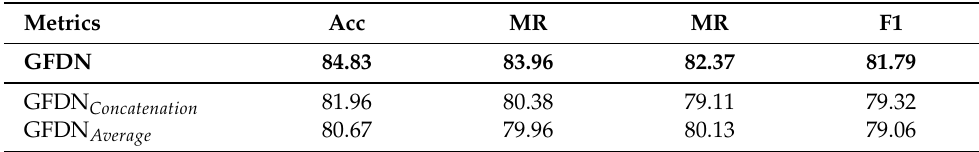
Table 8. Fusion ablation experiment results on dataset CAIL-small.